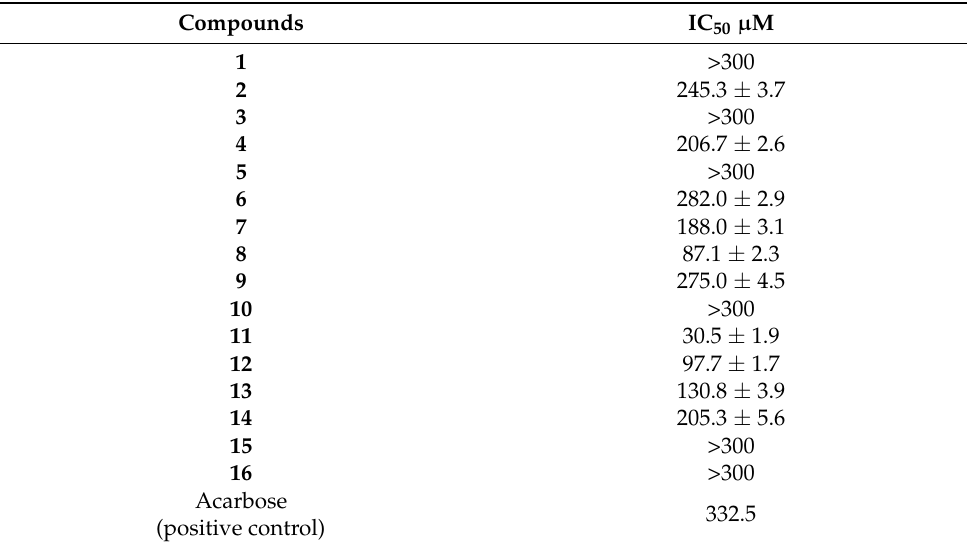
Table 1. Alpha-glucosidase inhibitory (IC 50 ) of compounds 1 – 16. Values are means ± standard errors of three independent